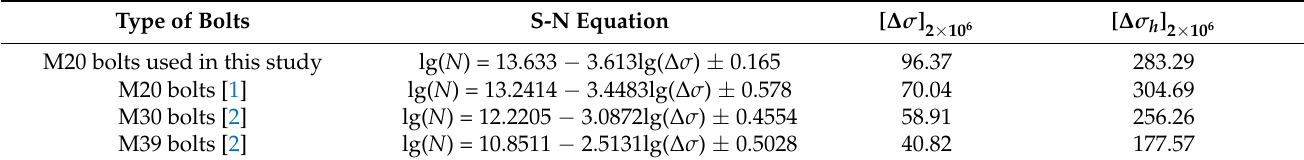
Table 4. Summary of S-N curves of high-tensile bolts [1,2].